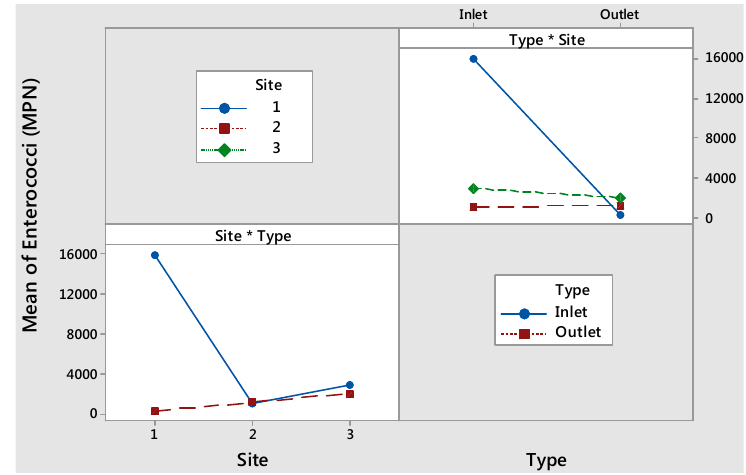
Figure 1. Interaction plots for enterococci for three bioretention cells in Grove, Oklahoma (Site 1 = GLA: Grand Lake Association, Site 2 = GHS: Grove High School, Site 3 = ECP: Elm Creek Plaza, Type = Inlet and Outlet, Inlet = inflow from the inlet, Outlet = outflow from the underdrain).